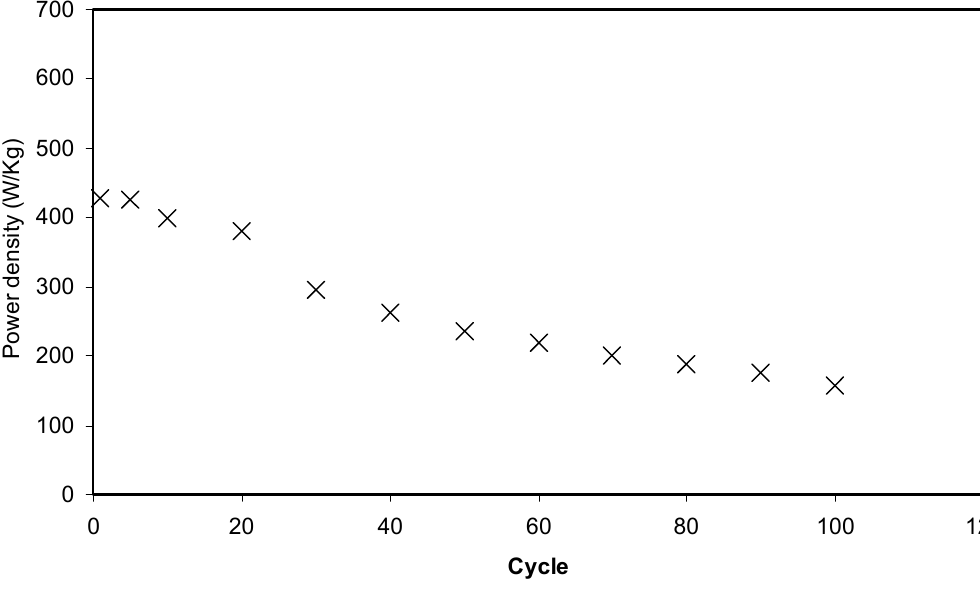
Figure 15. Power density of the fabricated EDLC for 100 cycles.